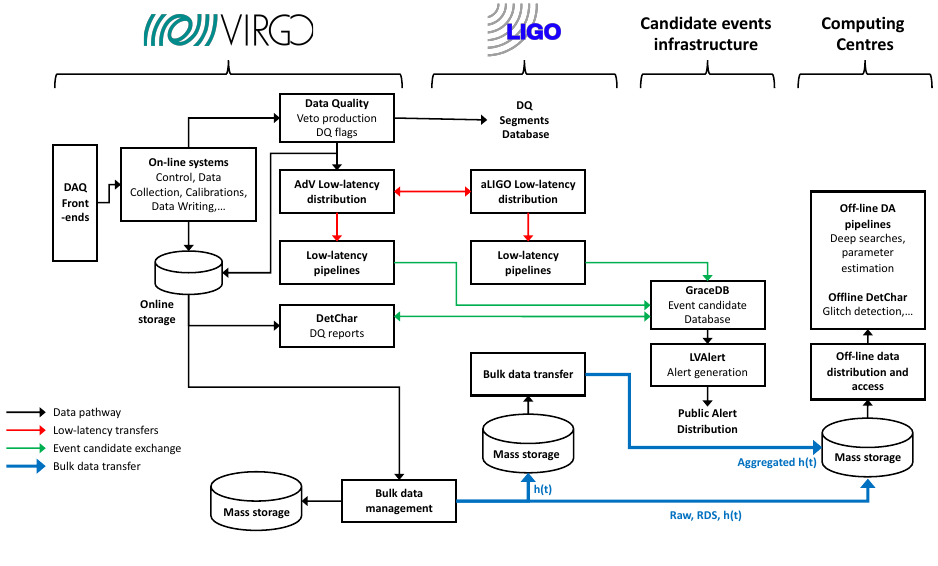
Fig. 1. AdV dataflow